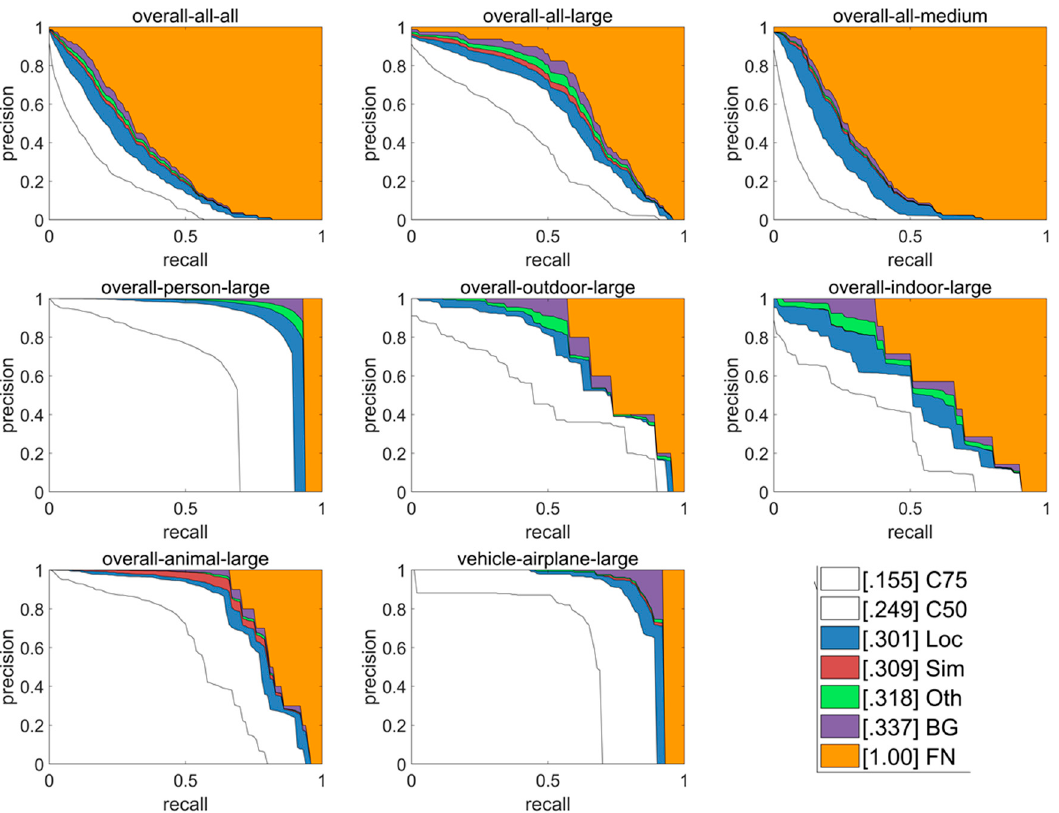
Figure 9. Detailed breakdown of false positives. Sensors 2020 , 20 , x FOR PEER REVIEW